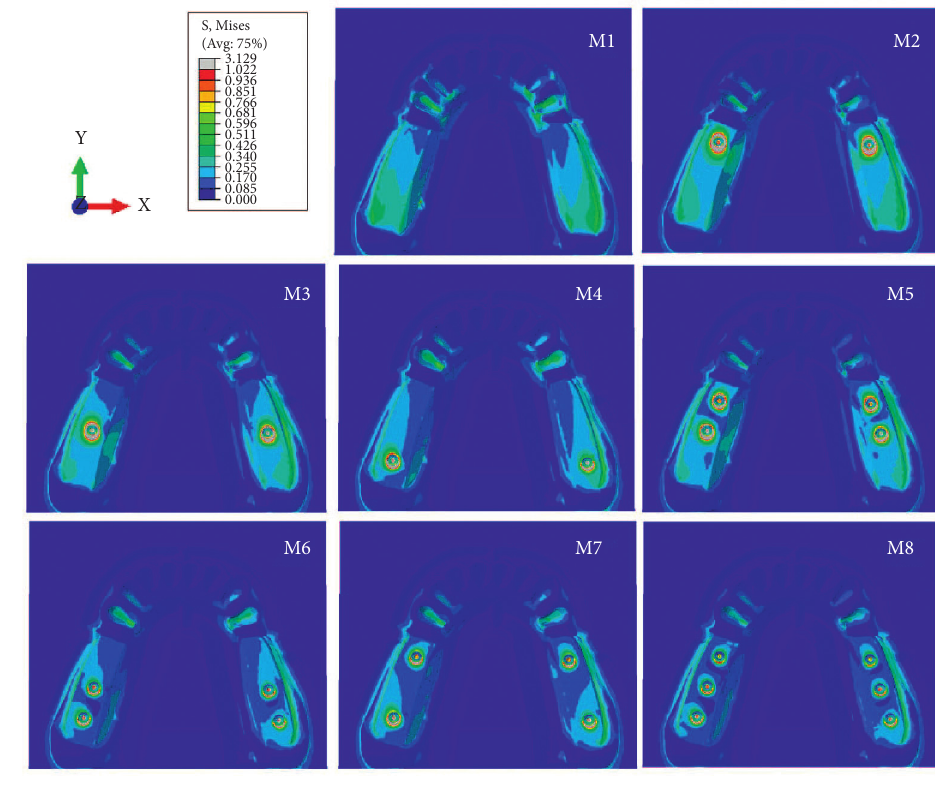
Figure 3: Stress pattern occurring in model nos.